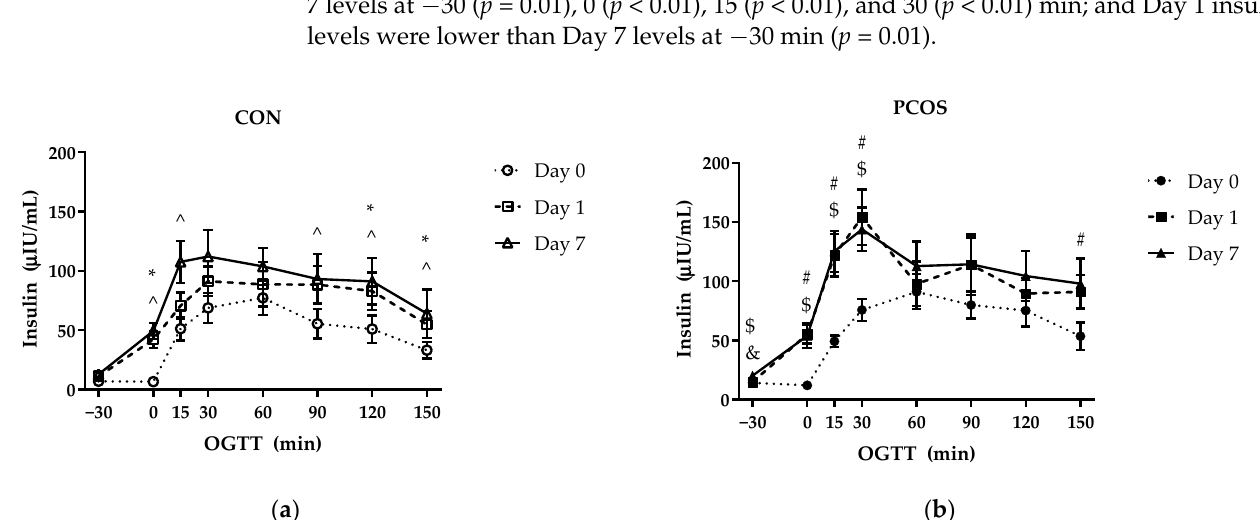
8 of 20 Figure 3. Glucose iAUC mean values (±SE) in CON ( n = 15) and PCOS ( n = 14). * = significance between days; ** = significance between groups for day, p < 0.05. CON = non-PCOS women; iAUC = incremental area under the curve; PCOS = women with polycystic ovarian syndrome. 3.3. Insulin and Insulin IAUC An interaction effect of time × day × group [F(14, 364) = 1.85, p = 0.03, η p 2 = 0.07] was found for insulin concentrations (Figure 4). Post hoc tests revealed a difference on Day 7 for baseline values between groups ( p = 0.03), as depicted in Figure 4. Insulin values in- creased across timepoints 15, 30, 60, 90, and 120 min from baseline values on Day 0 for